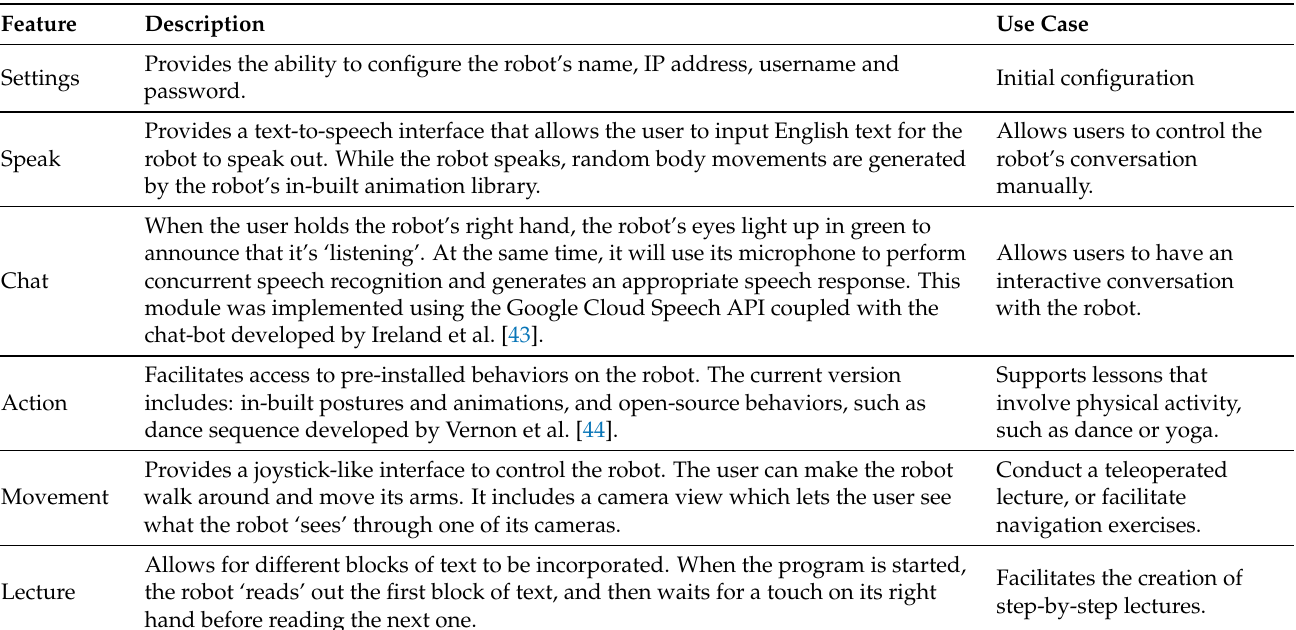
Table 1. Features of the android app and use